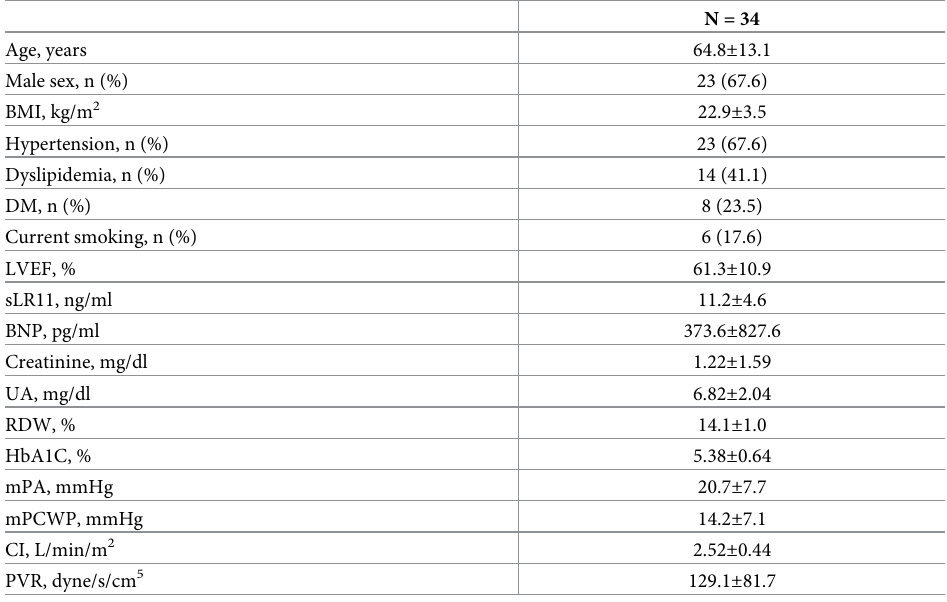
Table 1. Baseline clinical characteristics of the study